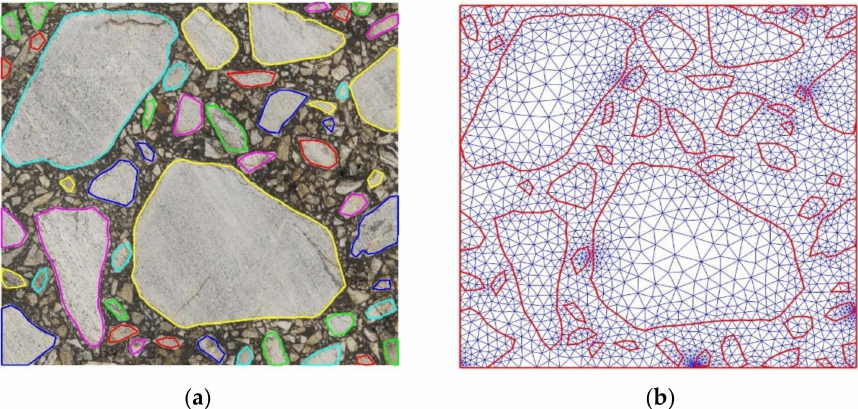
Figure 7. Boundaries of the simplified inclusions overlaid on the original image ( a ) and the corre- sponding fine mesh ( b